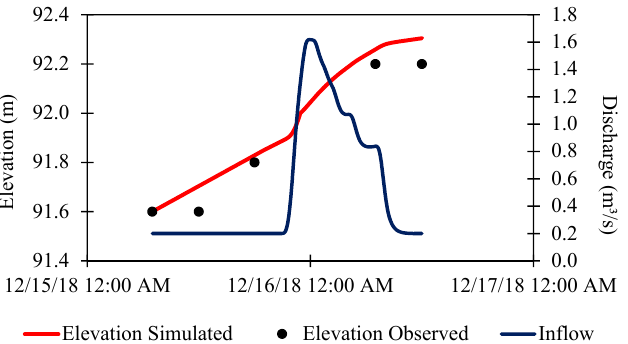
Figure 10. Validation of CN value for the SCS method with the reservoir water elevation recorded at Ketro Dam.